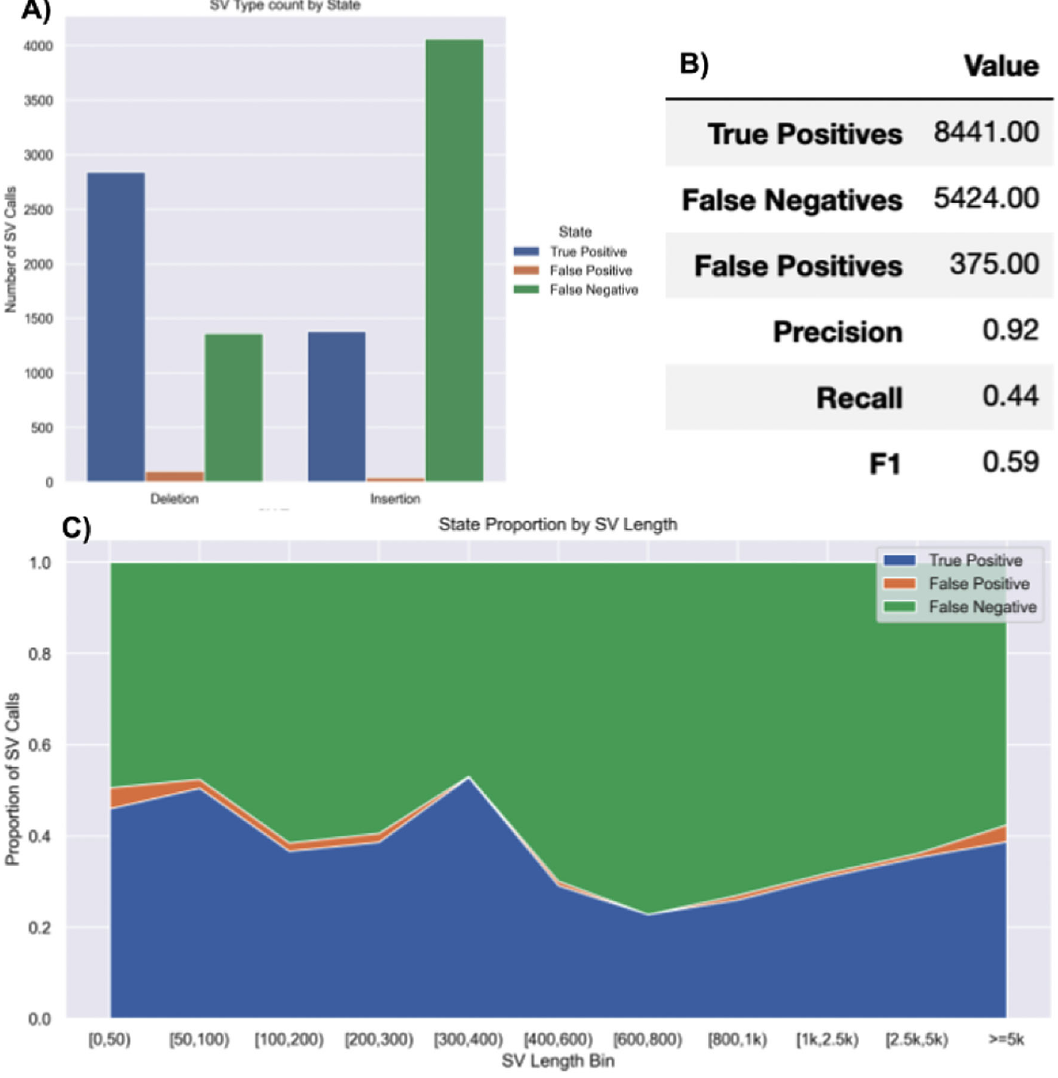
Figure 17. Summary report output of SVTeaser. A report generated from benchmarking a real HG002 Manta 30x Illumina sample against GIAB Tier1 SVs. A) Counts of SVs by SVType and their intersection state with GIAB